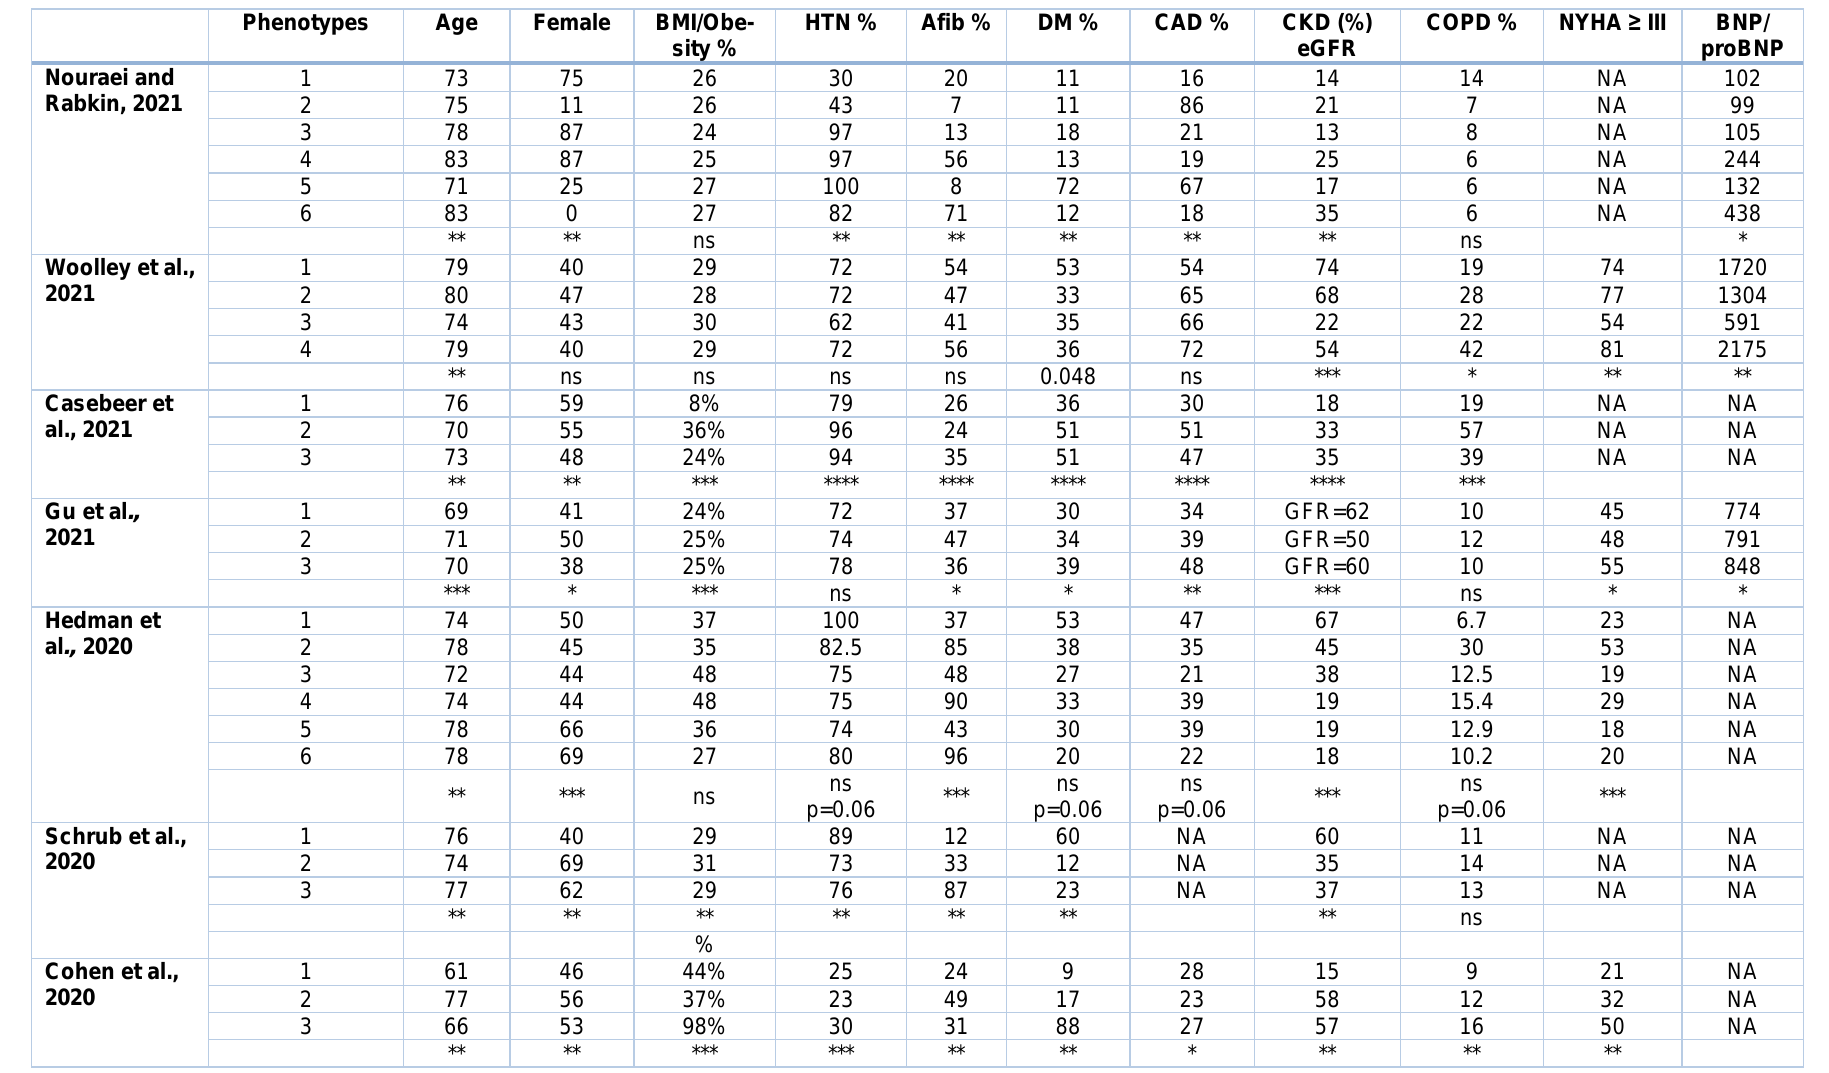
Table 2: Clinical characteristics of each phenotype in the ten